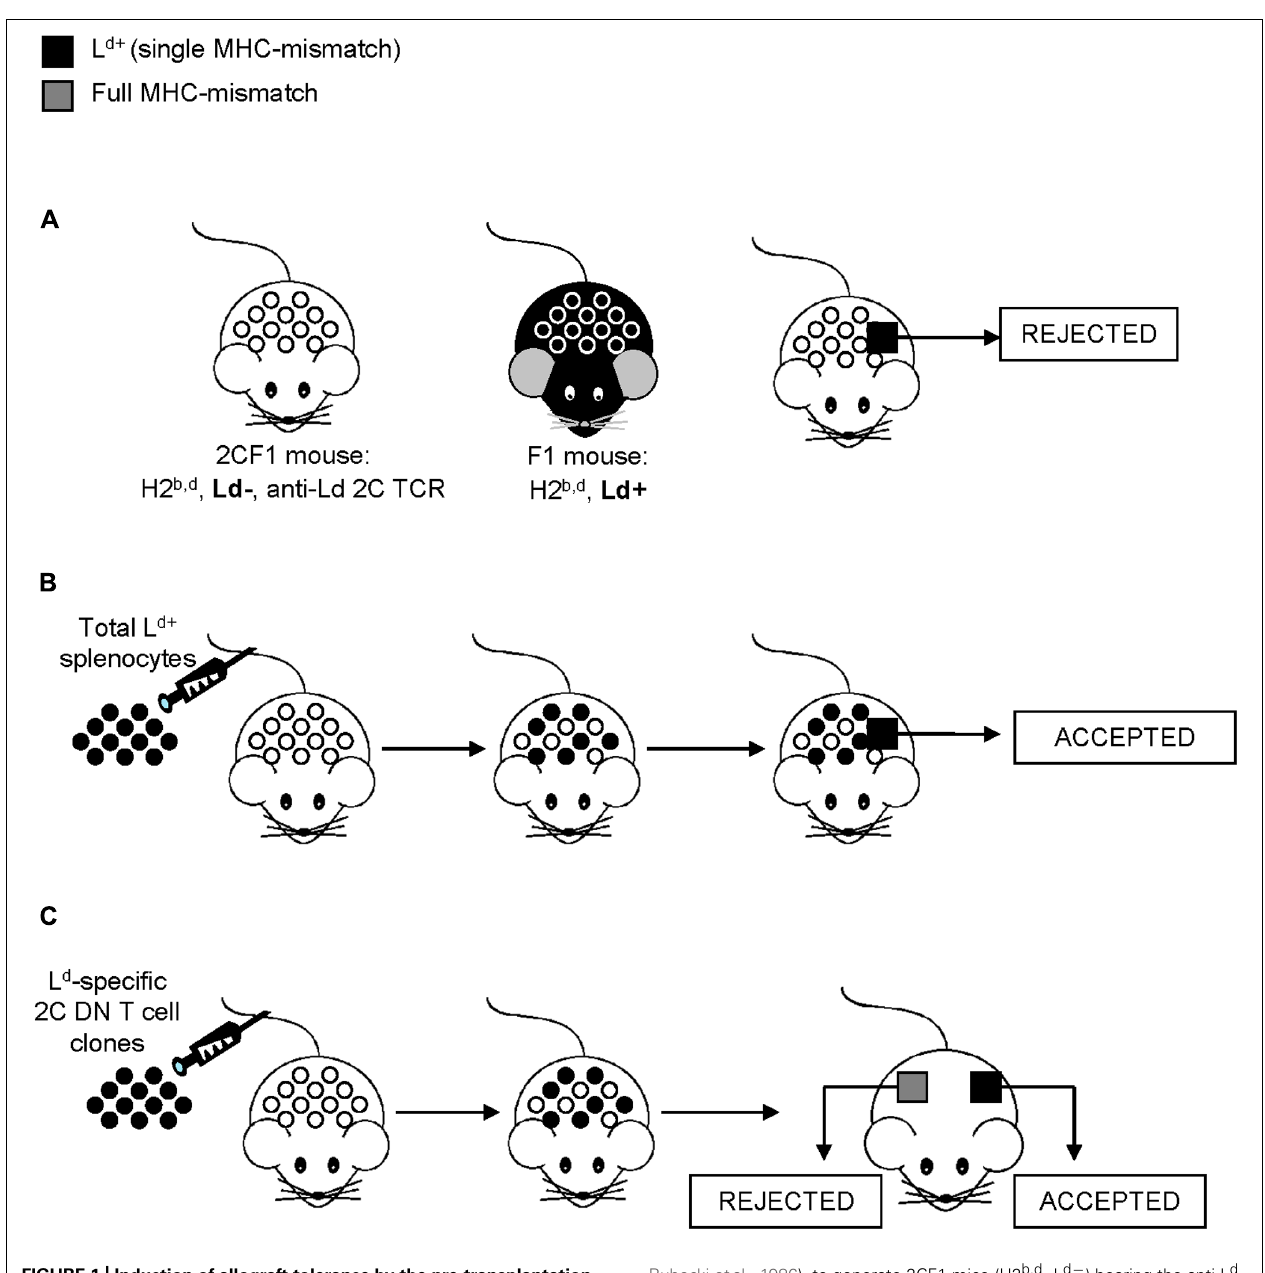
Rubocki etal., 1986), to generate 2CF1 mice (H2 b,d , L d − ) bearing the anti-L d TCR (white mouse). Due to a single MHC-mismatch, skin grafts from L d + F1 mice are rapidly rejected by the 2CF1 mice. (B) However, the transfer of donor spleen cells from L d + F1 mice to 2CF1 mice (L d − ) prior to the L d + skin graft transplantation results in graft survival. (C) Immunoregulatory 2C DNT cell clones obtained from 2CF1TCR transgenic mice (L d − ) prevent the rejection of single MHC-mismatch, allogeneic (L d + , in black) skin grafts. However, full MHC-mismatch, third party grafts (in gray) were